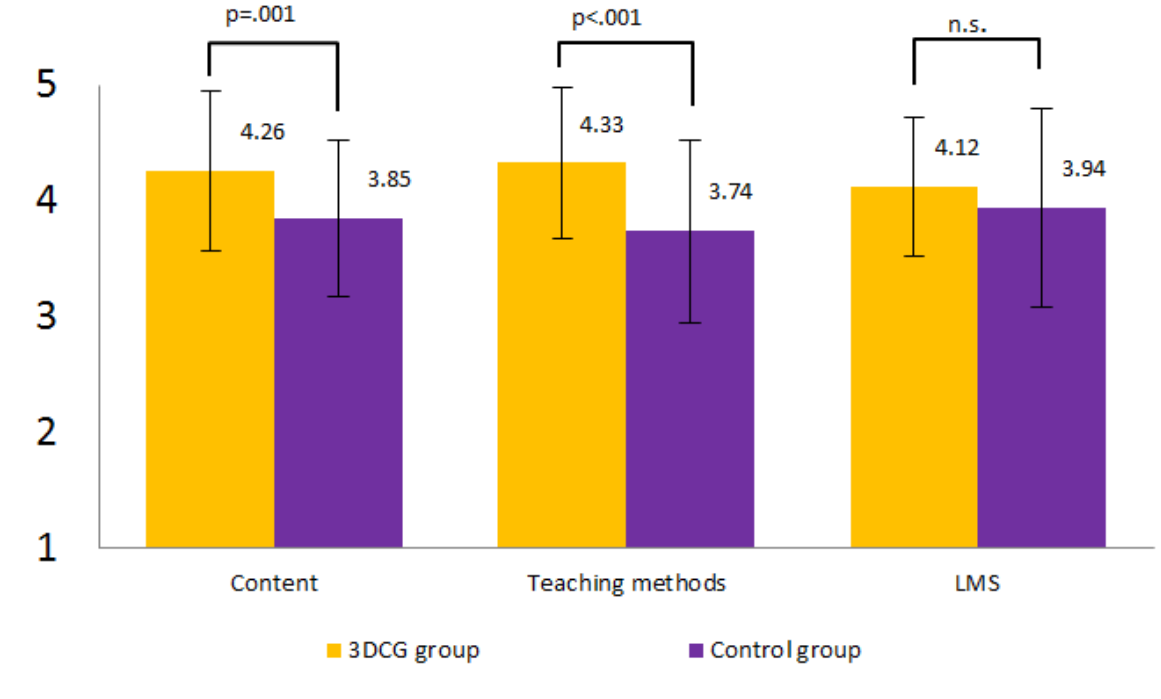
Figure 5. Mean scores of the 3-dimensional computer graphics (3DCG) and control groups for the three main categories. LMS = learning management system, n.s. = not significant.